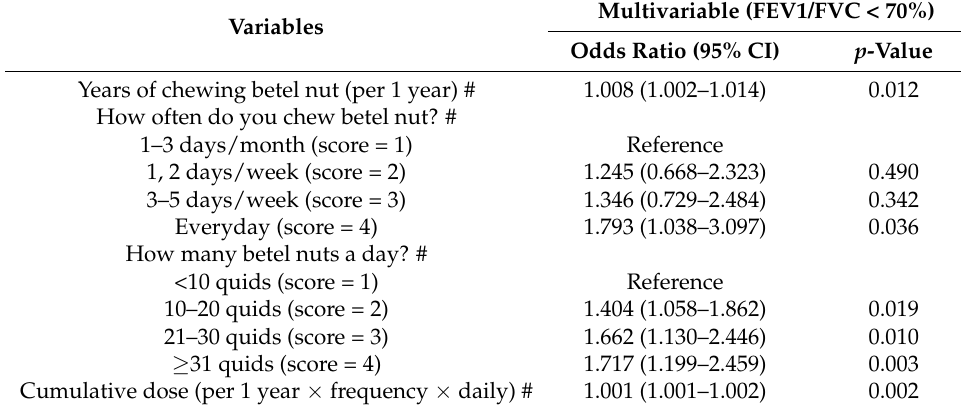
Table 4. Association of betel nut chewing characteristics with FEV1/FVC < 70% in study participants with betel nut chewing history ( n = 5135) using multivariable logistic regression